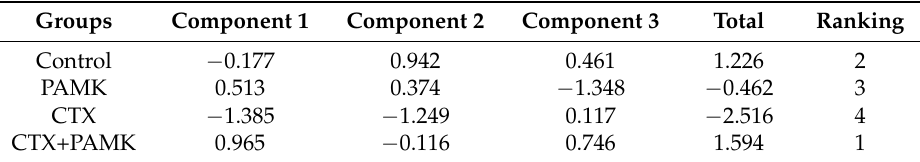
Table 3. Scores of the four groups of geese on three principal components.